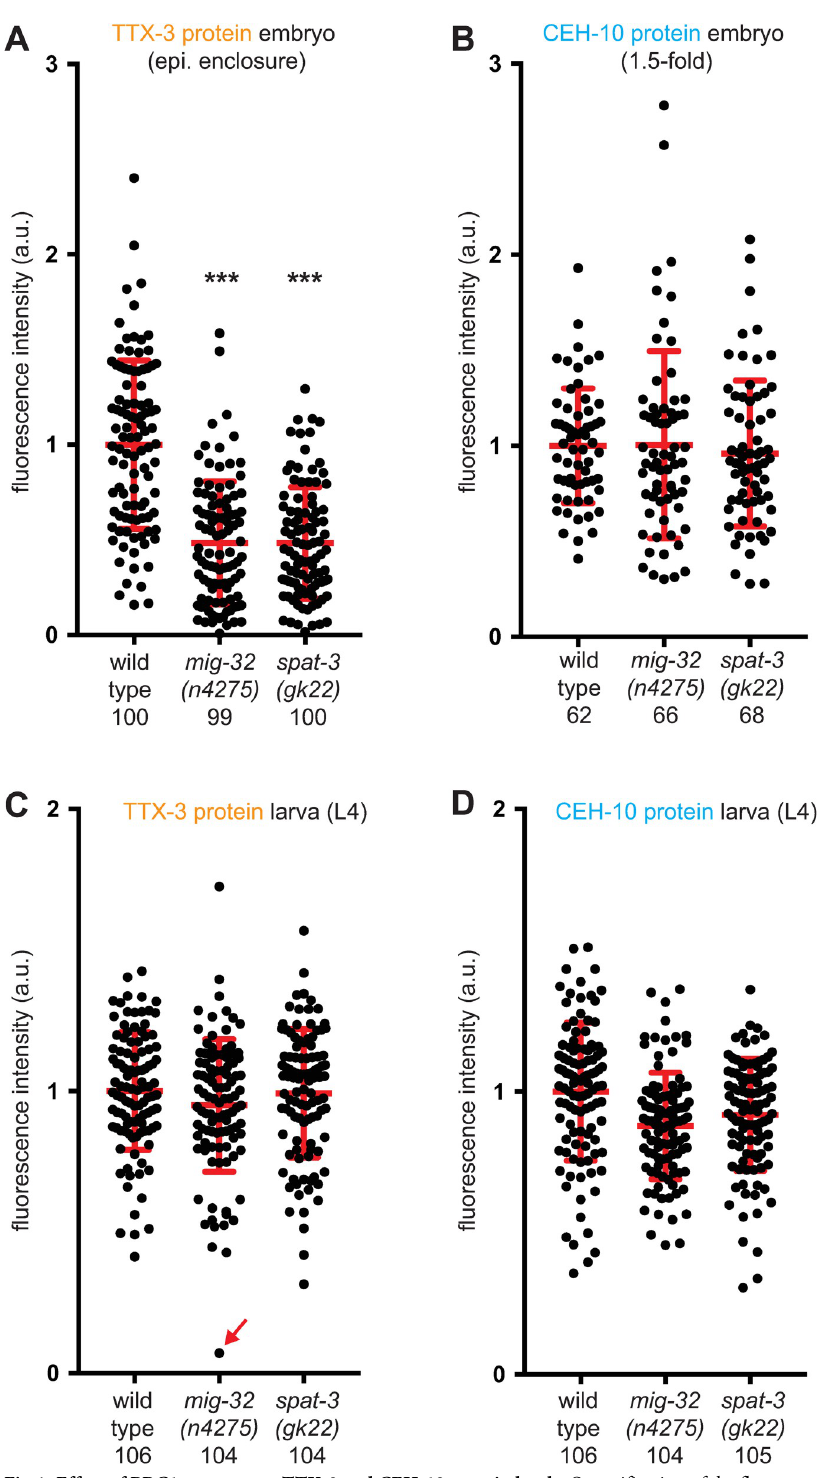
Fig 4. Effect of PRC1 mutants on TTX-3 and CEH-10 protein levels. Quantification of the fluorescence levels (arbitrary units) in AIY neurons of: (A) TTX-3 protein ( ttx-3endo :: yfp (vba3) ) at epidermal enclosure embryonic stage; (B) CEH-10 protein ( ceh-10endo :: yfp (vba1) ) at 1.5-fold embryonic stage; (C, D) TTX-3 protein ( ttx-3endo :: mkate2 (vba6) ) and CEH-10 protein ( ceh-10endo :: yfp (vba1) ) at L4 larval stage in the same neurons. Only neurons where expression was detected were analyzed. Each dot represents one neuron. The number of positive neurons analyzed